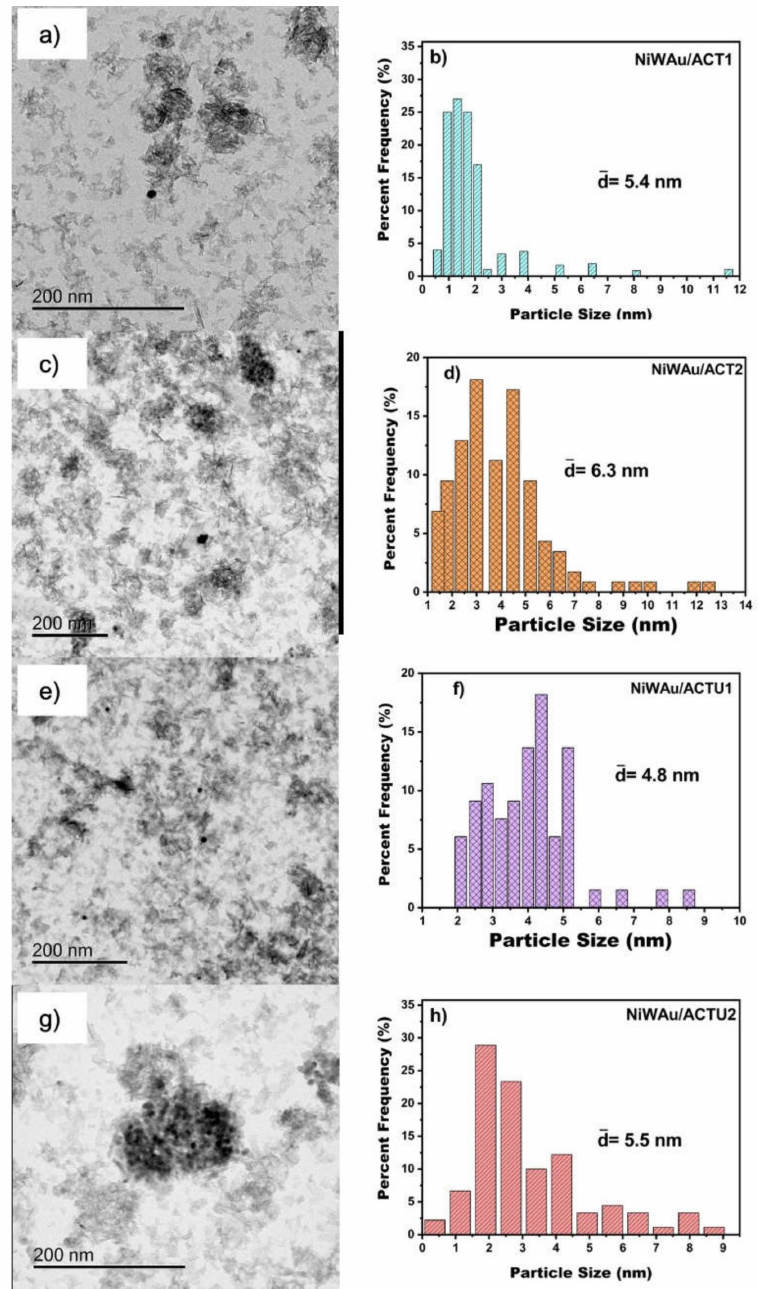
Figure 11. TEM image and particle size distributions (right side) of the nanomaterials ( a , b ) Ni- WAu/ACT1, ( c , d ) NiWAu/ACT2, ( e , f ) NiWAu/ACTU1 and ( g , h ) NiWAu/ACTU2 prepared by the recharge